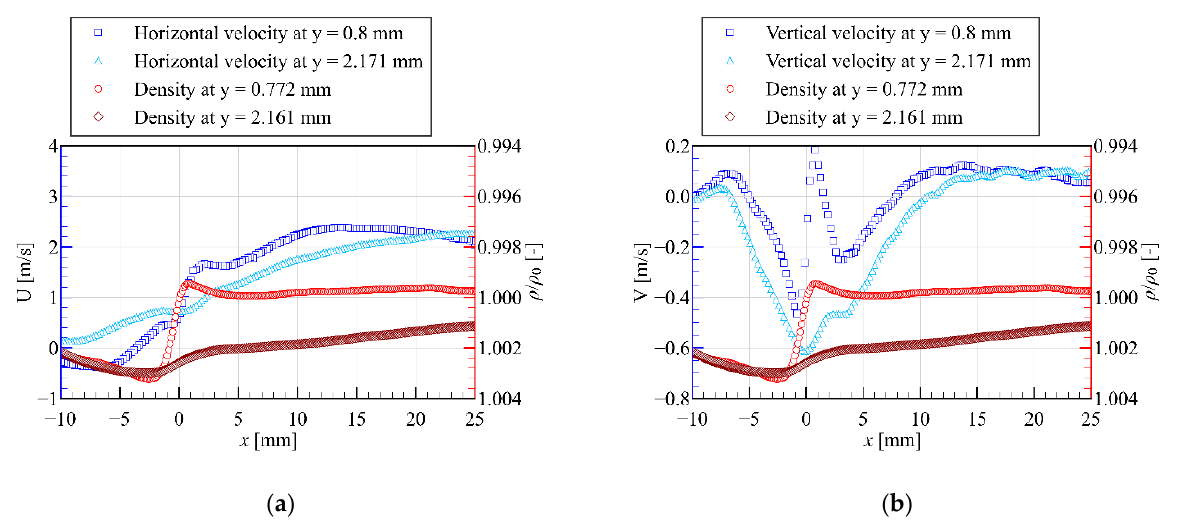
Figure 17. x -profiles of the flow, density field of the wire-PA: ( a ) x -profiles of the horizontal velocity ( y = 0.8 and 2.171 mm) and density ( y = 0.772 and 2.161 mm); ( b ) x -profiles of the vertical velocity ( y = 0.8 and 2.171 mm) and density ( y = 0.772 and 2.161 mm).